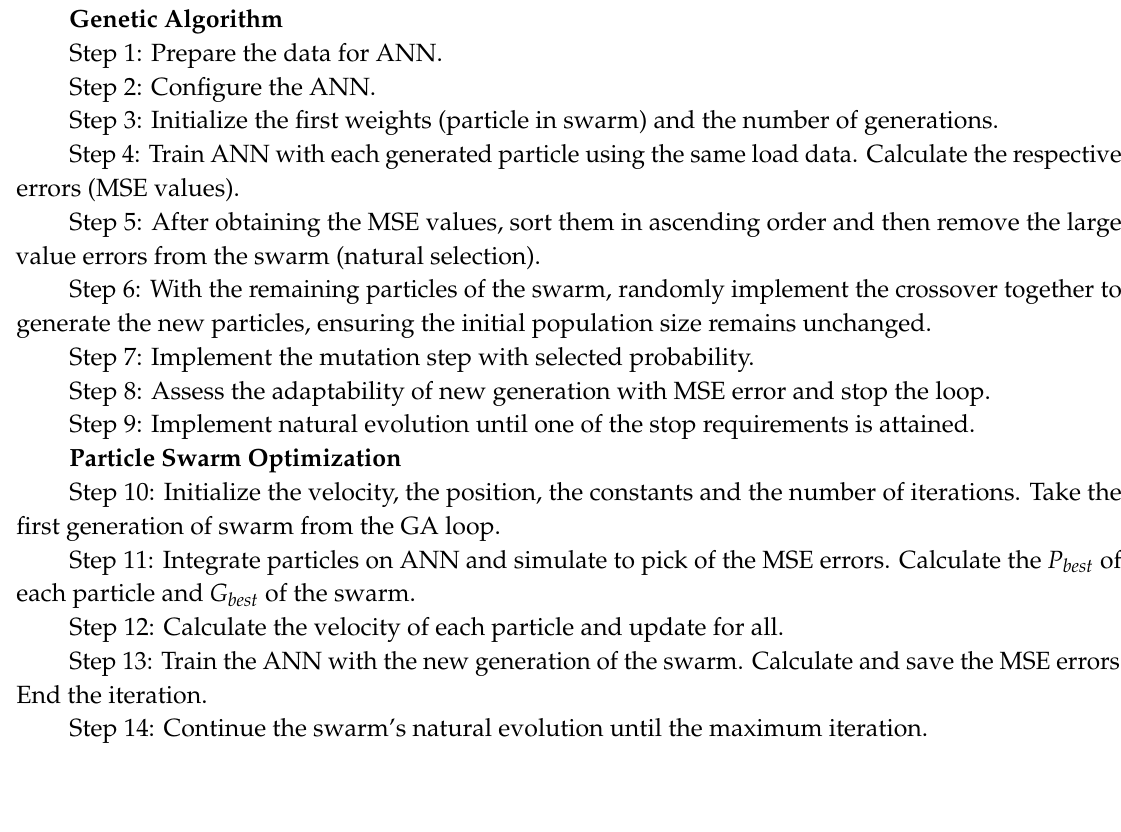
Figure 8. The schema of the hybrid GA-PSO algorithm. Genetic Algorithm